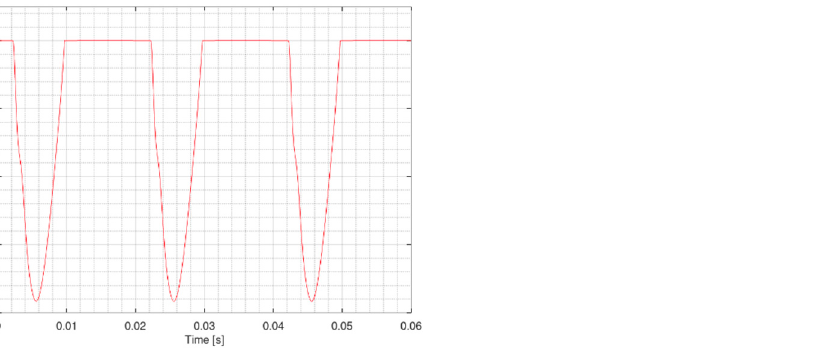
Figure 9. Current through the nonlinear element in the time domain (Illustrative Example 1).